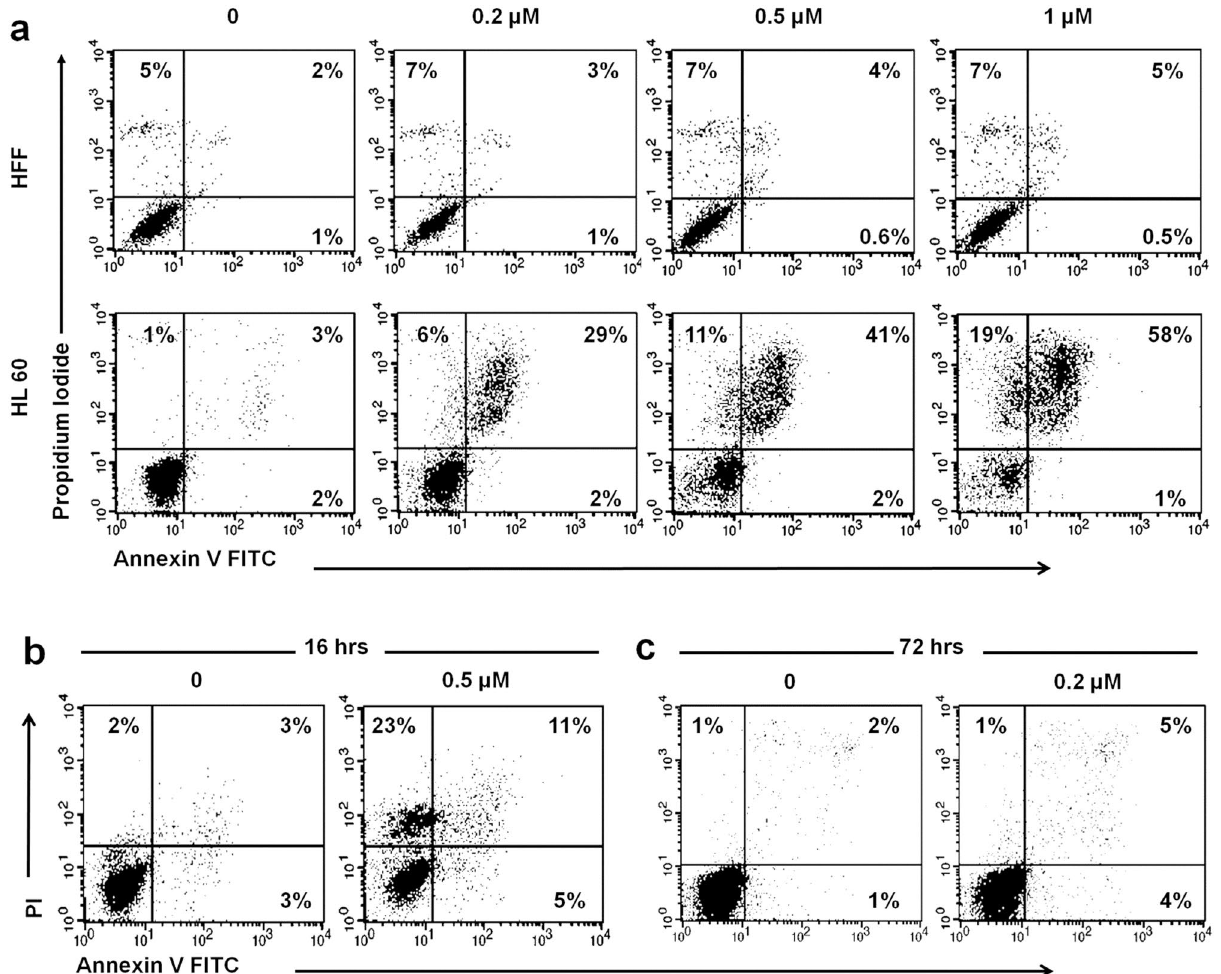
Figure 4. Flow cytometry analysis of fenbendazole treated cells with Annexin V-FITC: ( a ) concentration dependent selective cell death induced in HL60 leukaemia cells by fenbendazole compared to Human Foreskin Fibroblast cells (HFF); ( b ) 16 h post 0.5 µM fenbendazole treatment (16% apoptotic (Annexin+) and 23% necrotic cells (Annexin−, PI+)); ( c ) 72 h post 0.2 µM of fenbendazole (8% apoptotic (Annexin+)